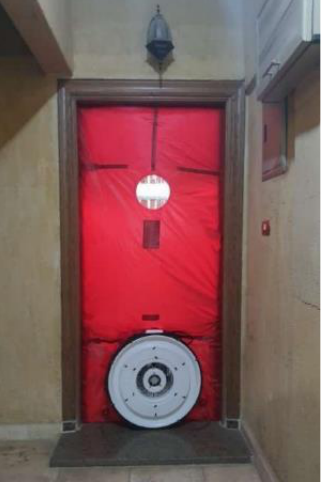
Figure 4. Minneapolis Blower Door system during the testing.